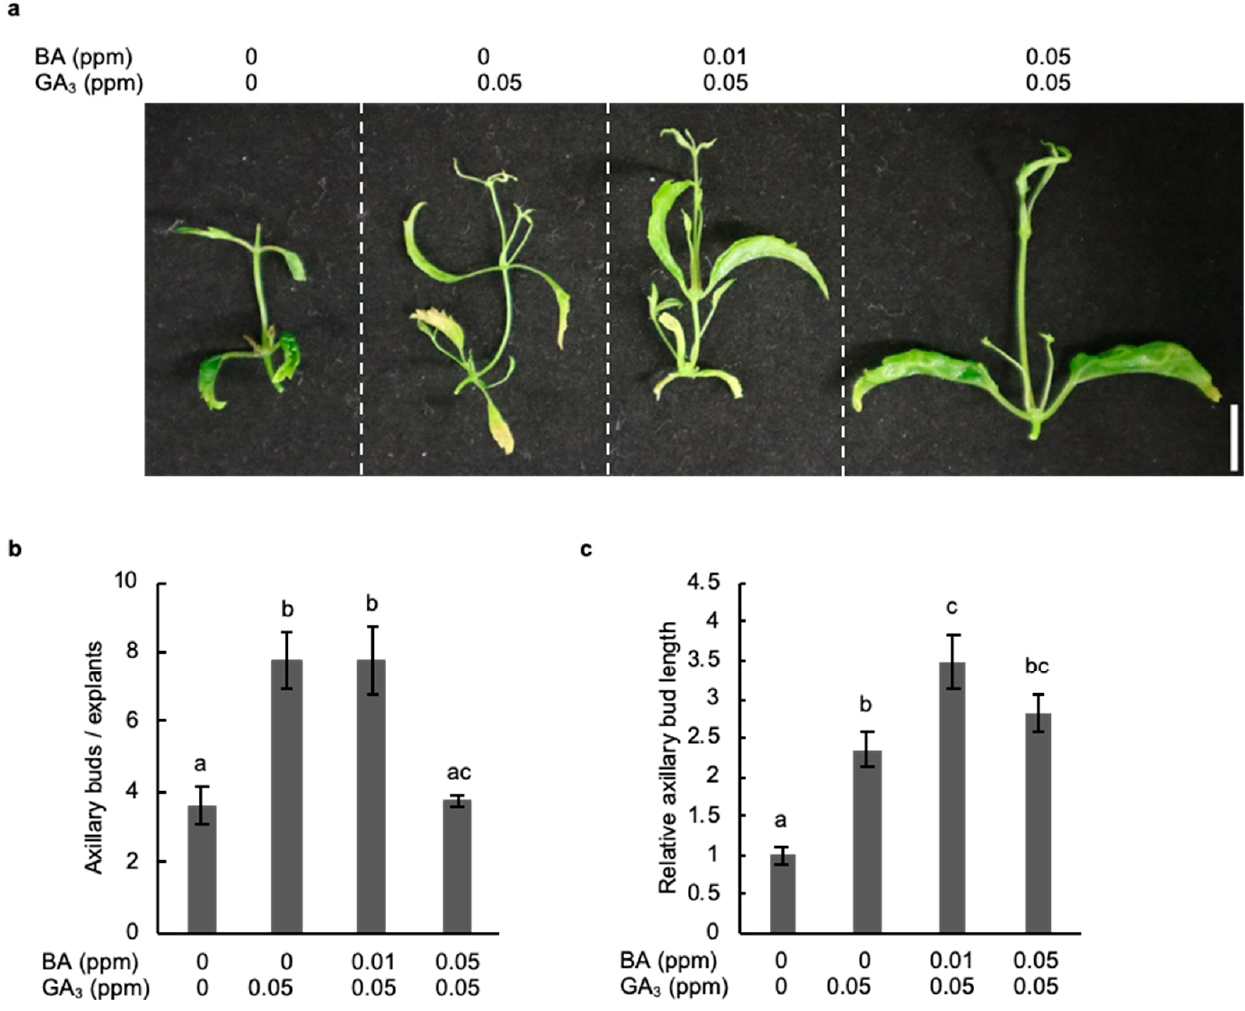
Figure 4. Combination treatment with GA 3 and BA strongly induces the development of axillary buds in hop. ( a ) Stem explants of hop cultivar Kirin-2 cells were treated with GA 3 and BA for 3 weeks. Scale bar: 1 cm. ( b ) Number of axillary buds in stem explants with GA 3 and BA for 3 weeks ( n ≥ 14, individual experiment, p < 0.05; Tukey–Kramer test). Different letters indicate significant differences. ( c ) Relative length of axillary buds of stem explants treated without and with GA 3 and BA for 3 weeks. The axillary bud length of explants treated with GA 3 and BA was normalized against the axillary bud length of explants without GA 3 and BA for 3 weeks ( n ≥ 22, individual experiment, p < 0.05; Tukey–Kramer test). Different letters indicate significant differences.